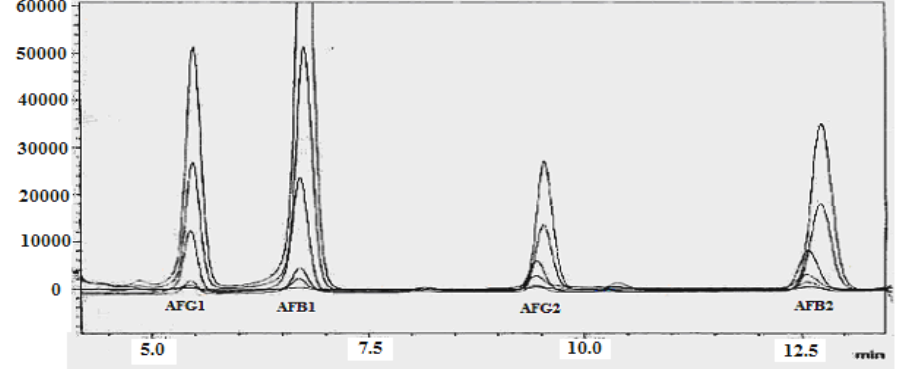
Figure 2. HPLC chromatogram showing the repeatability and reproducibility of AFGl, AFBl, AFGl and AFB2